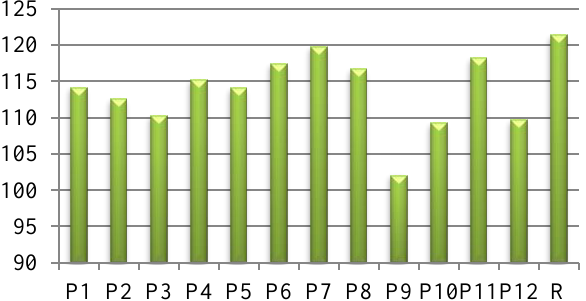
Figure 12. Contact angle values of dyed wool (P1–P12) and raw (R) fabrics. This behavior could be explained by the hydrophilic groups present in the Chelidonium majus extracts used as dyeing agents, mainly of the polyphenol hydroxyl groups. In addition, the pre-treatment applied to the raw fiber before dyeing (UV exposure and citric acid treatment) could modify not only the fiber morphology but also the chemical reactivity on the outer layer of the wool fiber. Based on the contact angle values, the surface free energy (SFE) of the sample was calculated using Young’s complete Equation (3), which is the result of both apolar and polar interactions between solids and liquids [41].